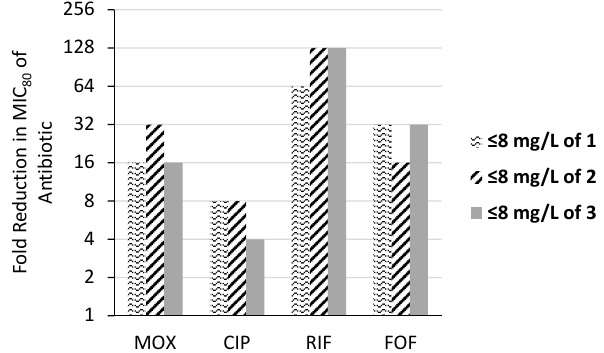
Figure 2. TOB-EPIs ( 1 , 2 or 3 ) potentiate the activity of moxifloxacin (MOX), ciprofloxacin (CIP), rifampicin (RIF) and fosfomycin (FOF) against a panel of MDR/XDR P. aeruginosa clinical isolates ( n = 8). The MIC 80 of MOX, CIP, RIF and FOF were significantly reduced in the presence of ≤ 8 mg/L × MIC (6.1–7.2 µ M) ( ≤ 1 adjuvant ) of the corresponding potentiator ( 1 , 2 , or 3 4